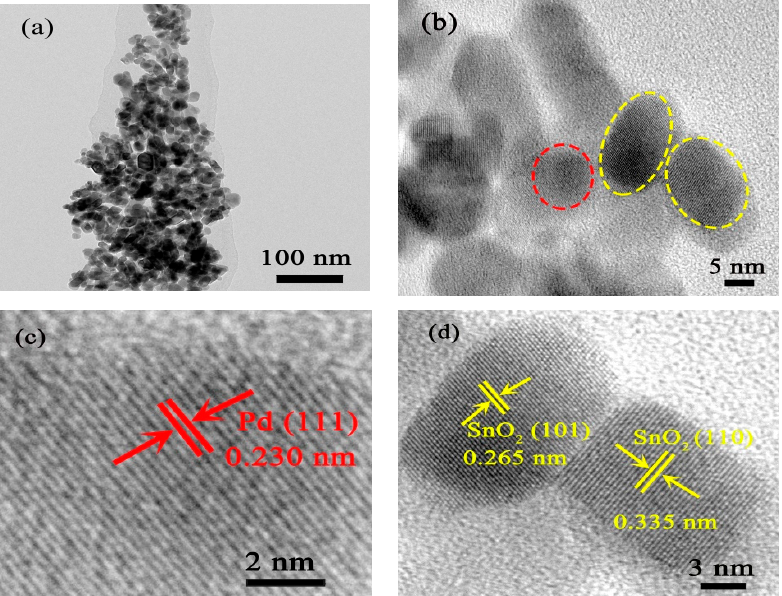
Figure 3. Transmission electron microscopy (TEM) ( a ) and high-resolution transmission electron microscopy (HRTEM) ( b–d ) images of as-prepared 5 mol% Pd-functionalized SnO 2 nanofibers after annealing.